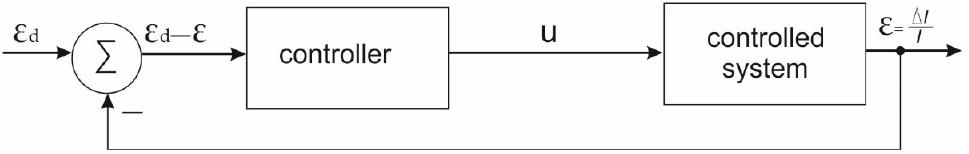
Figure 16. Block diagram of the control circuit.